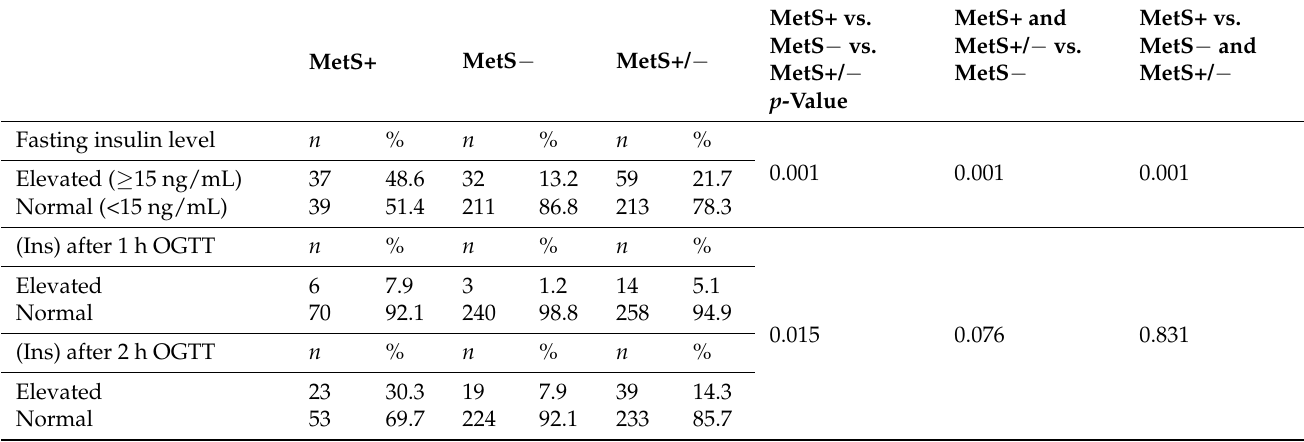
Table 4. Fasting insulin level (Ins), one and two hours after glucose intake (oral glucose tolerance test (OGTT)) in study population.